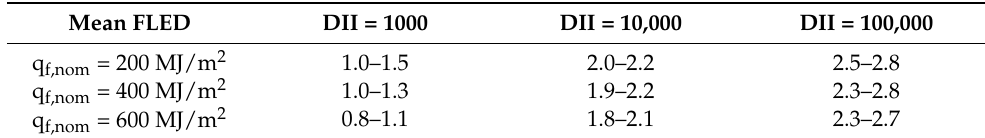
Table 6. β fi,opt in function of DII [mm 2 ] and mean FLED. Mean FLED DII = 1000 q f,nom = 200 MJ/m